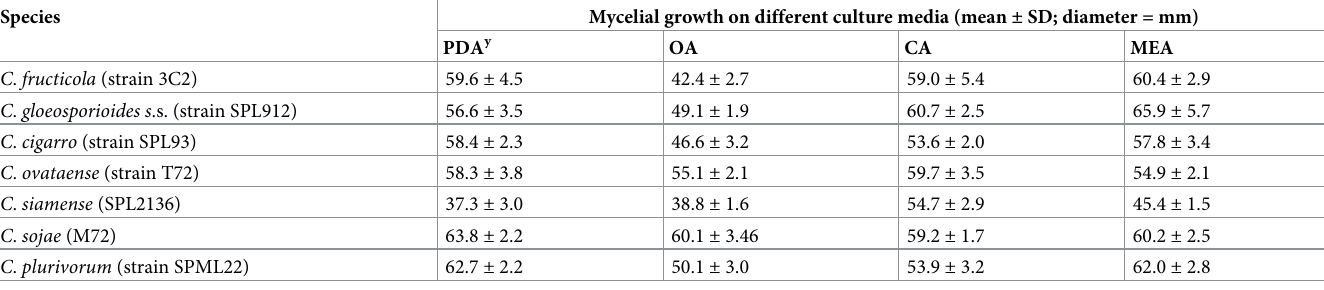
Table 2. Growth of Colletotrichum spp. on different culture media after seven days.